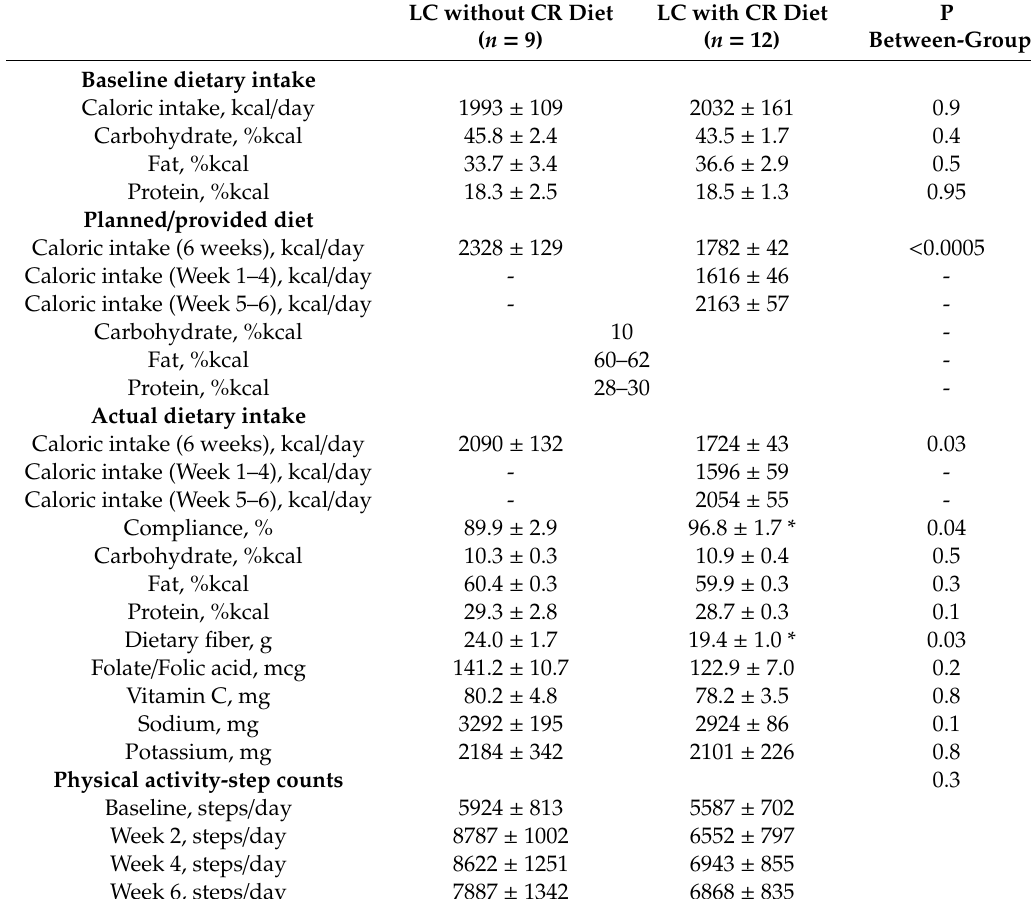
Table 1. Dietary intake and physical activity at baseline and during the 6-week low carbohydrate diet